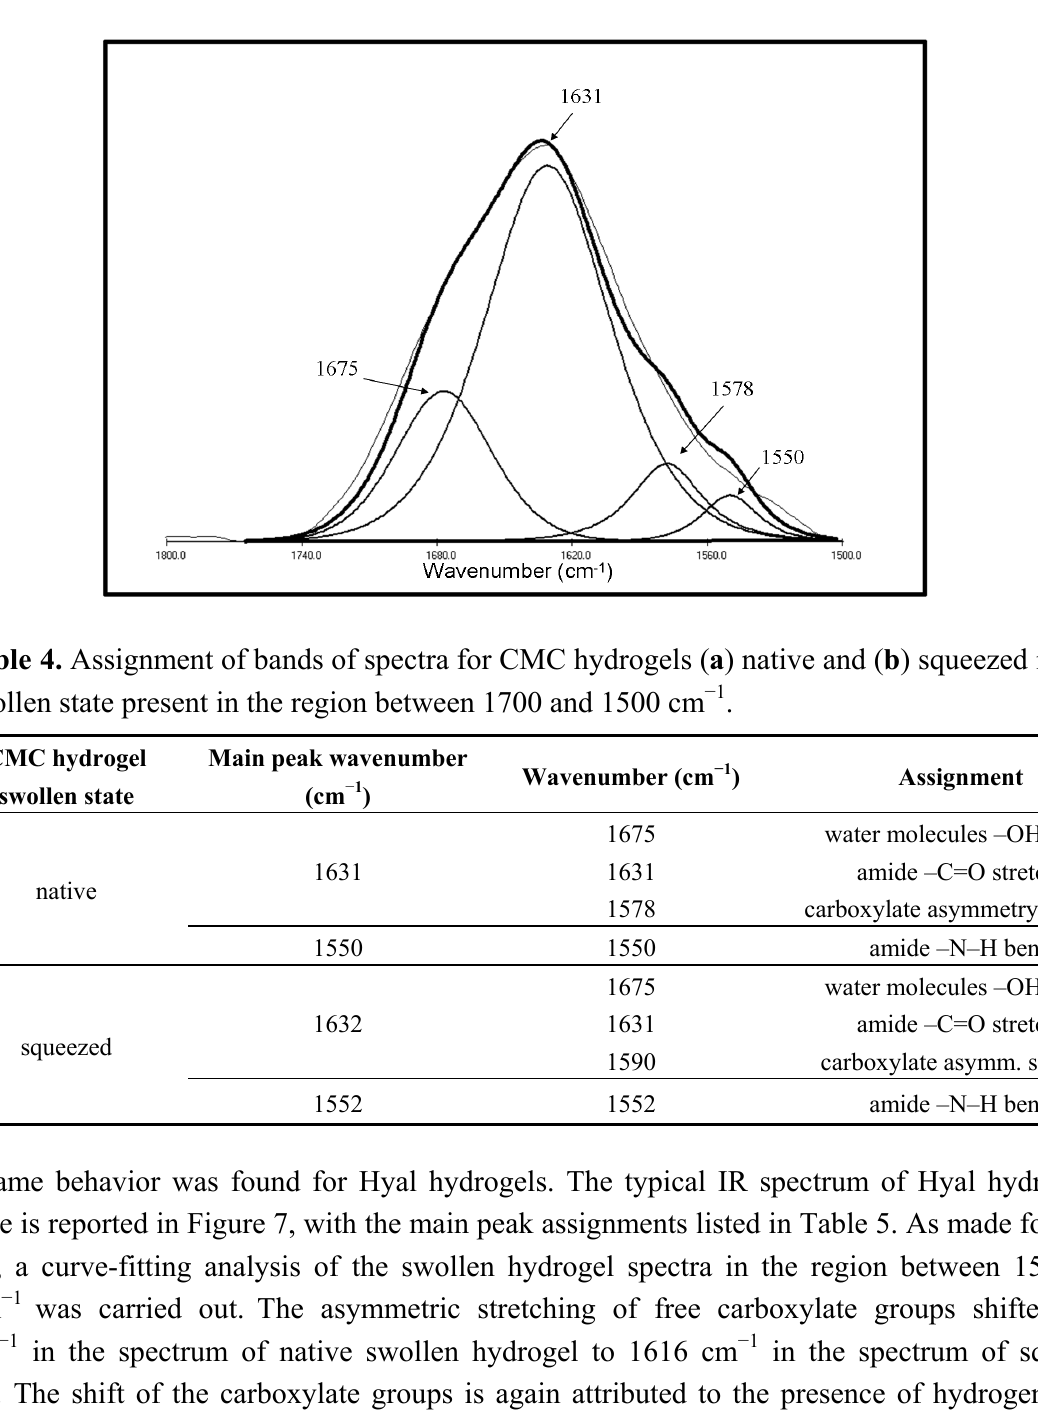
Figure 6. Curve-fitting analysis of the spectrum of swollen CMC hydrogel in native state. The components contributing to the peak were fitted using a mixture of Lorentzian and Gaussian line shapes. The component frequency, the full width, half, maximum and peak areas were optimized in the fitting procedure. The thick line represents the overall fit to four components.